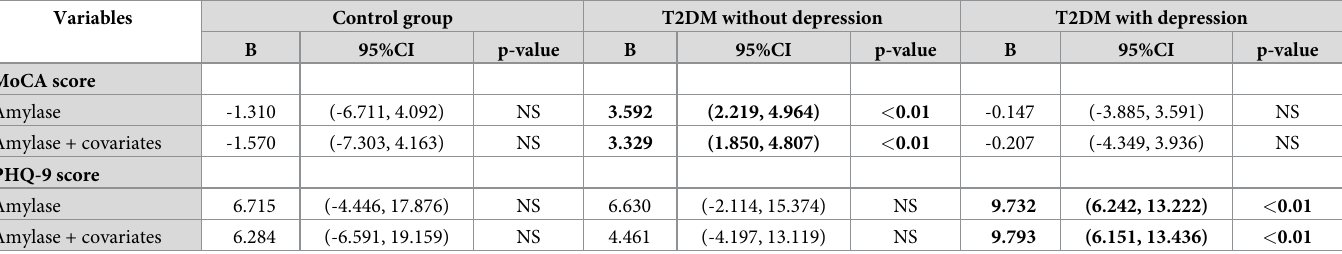
Table 3. Correlation between salivary-alpha amylase activity and MoCA and PHQ-9.